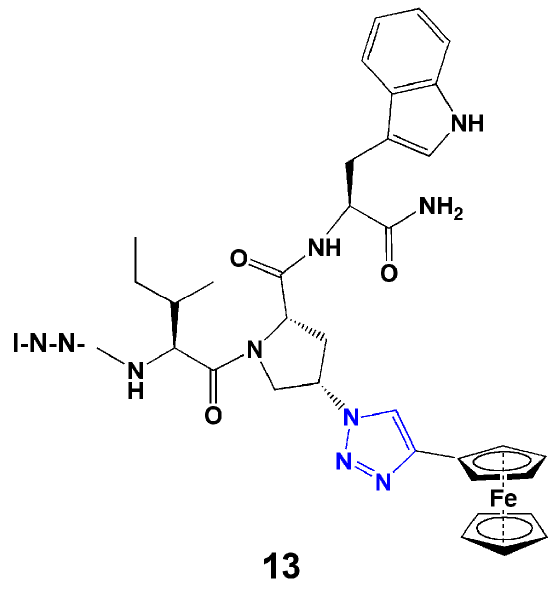
Figure 5. Structure of minimized peptide triazole,